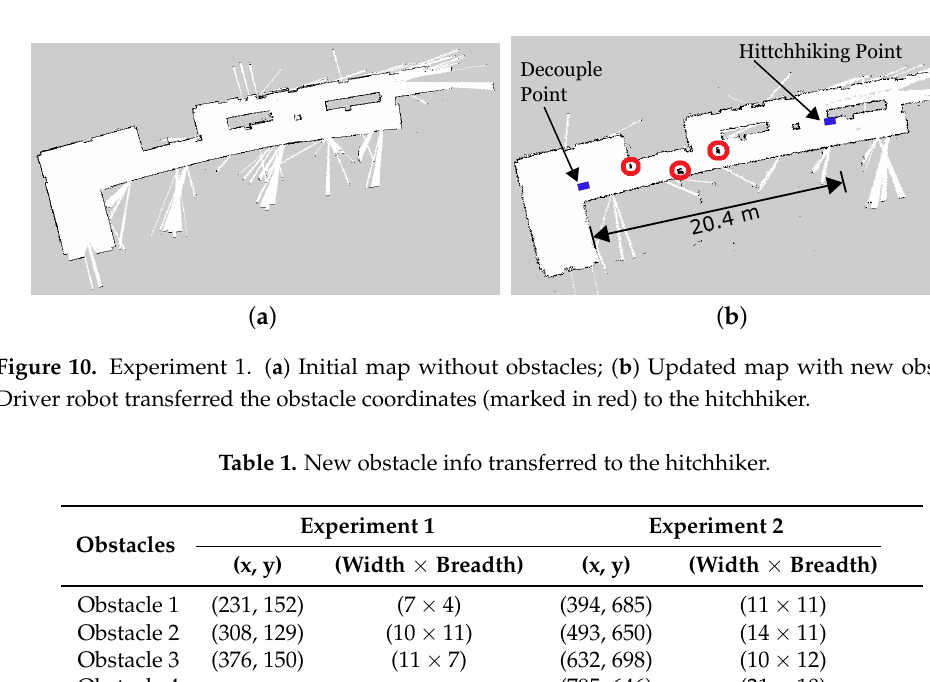
Figure 9. Experiment 1. ( a ) Environment with new obstacles marked in red; ( b ) Coupling between the two robots. The ‘+’ marker on pillar is marked in red circle; ( c ) Turtlebot following P3DX through visual servoing. (Refer the accompanied video provided in the Supplementary Materials section).